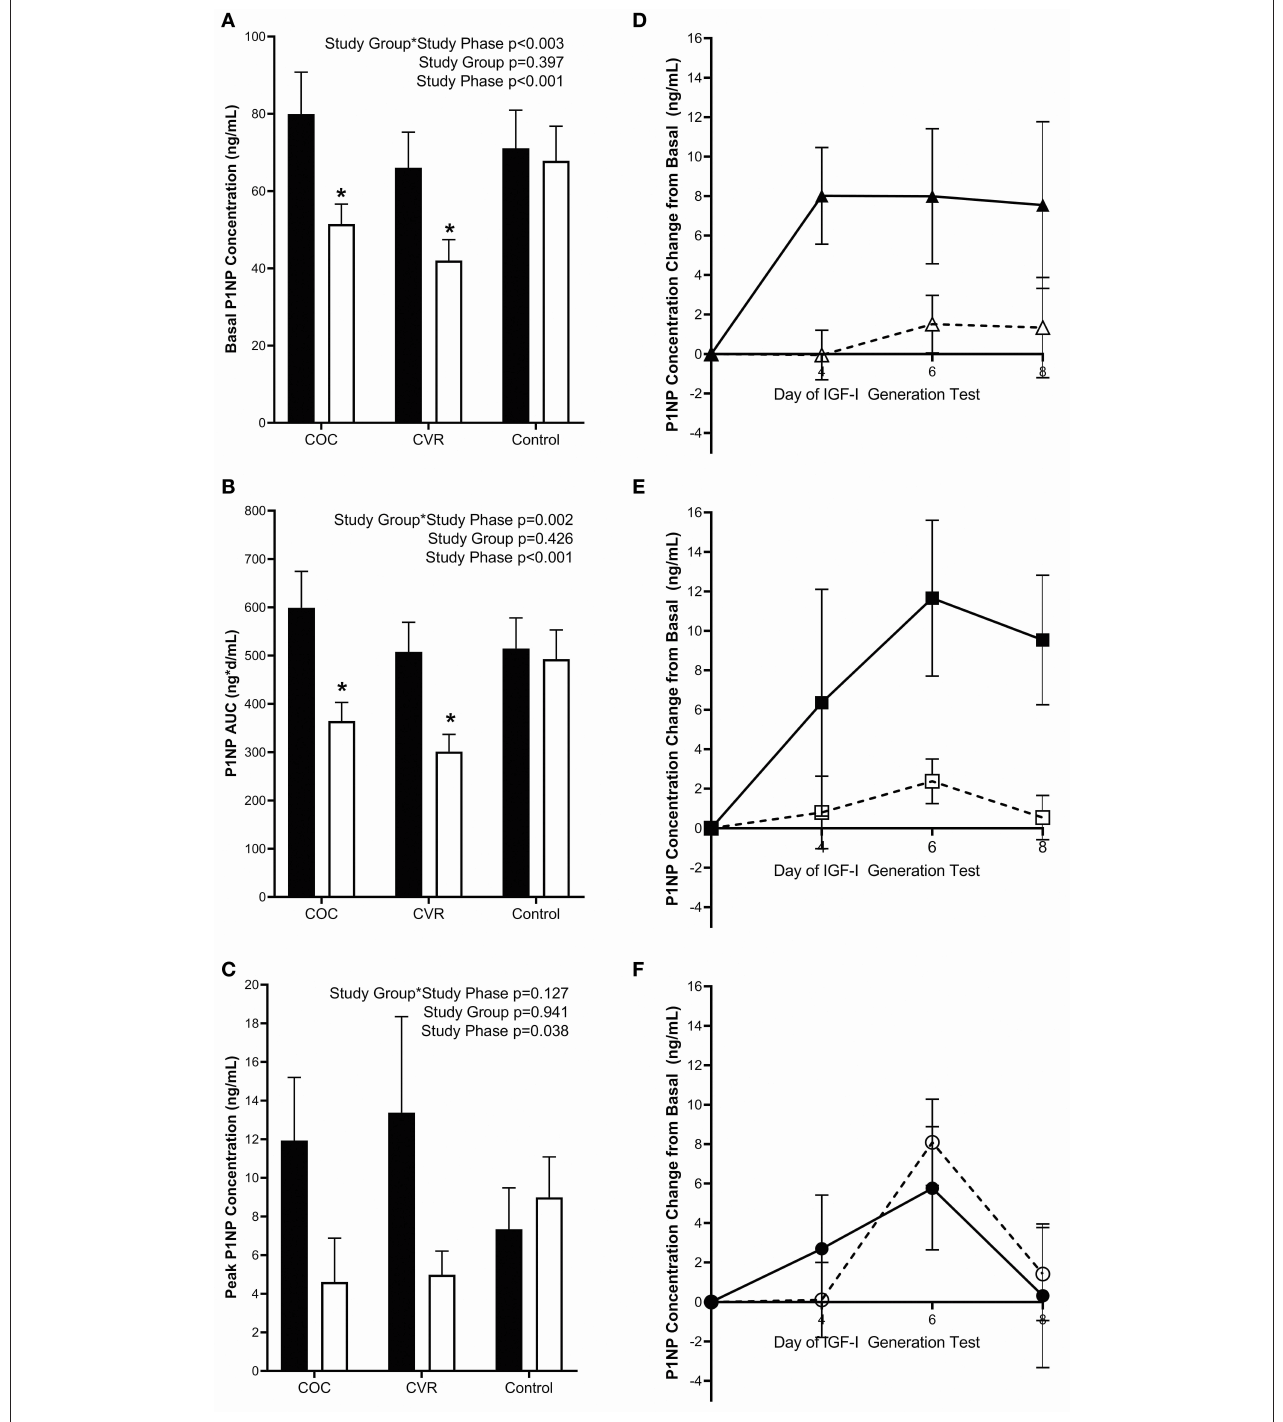
FIGURE 5 | Pre-intervention (black bars) and intervention (open bars) PINP (A) basal concentrations and response to the IGF-I Generation Test measured as (B) AUC and (C) peak concentrations for the COC, CVR, and Control Groups. (D–F) Daily concentrations of PINP for pre-intervention (solid lines and filled symbols) and intervention (dashed lines and open symbols) phase IGF-I Generation Tests. (D) COC group (triangles); (E) CVR group (squares); (F) Control group (circles). Basal PINP concentrations were subtracted from day 4, 6, and 8 concentrations for each study group and study phase (pre-intervention and intervention). COC, combined oral contraception; CVR, contraceptive vaginal ring; PINP, procollagen type I N-terminal propeptide; AUC, area under the curve. * indicates difference from pre-intervention phase within study group P < 0.05. ∧ indicates difference from Control group within study phase P < 0.05.